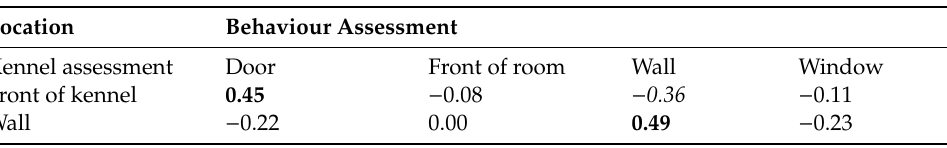
Table 7. Significant ( p < 0.05) Spearman Rank correlation coe ffi cients between locations recorded in kennel and formal behaviour assessment of shelter dogs ( n =